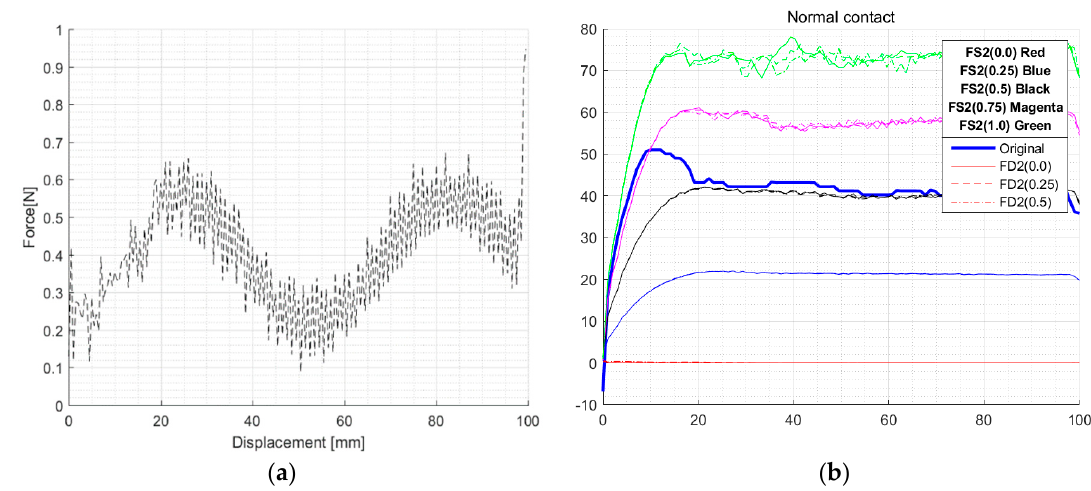
Figure 13. Grommet bonding force test results and FEA process and results; ( a ) Scale factor value not applied; ( b ) Scale factor value applied.